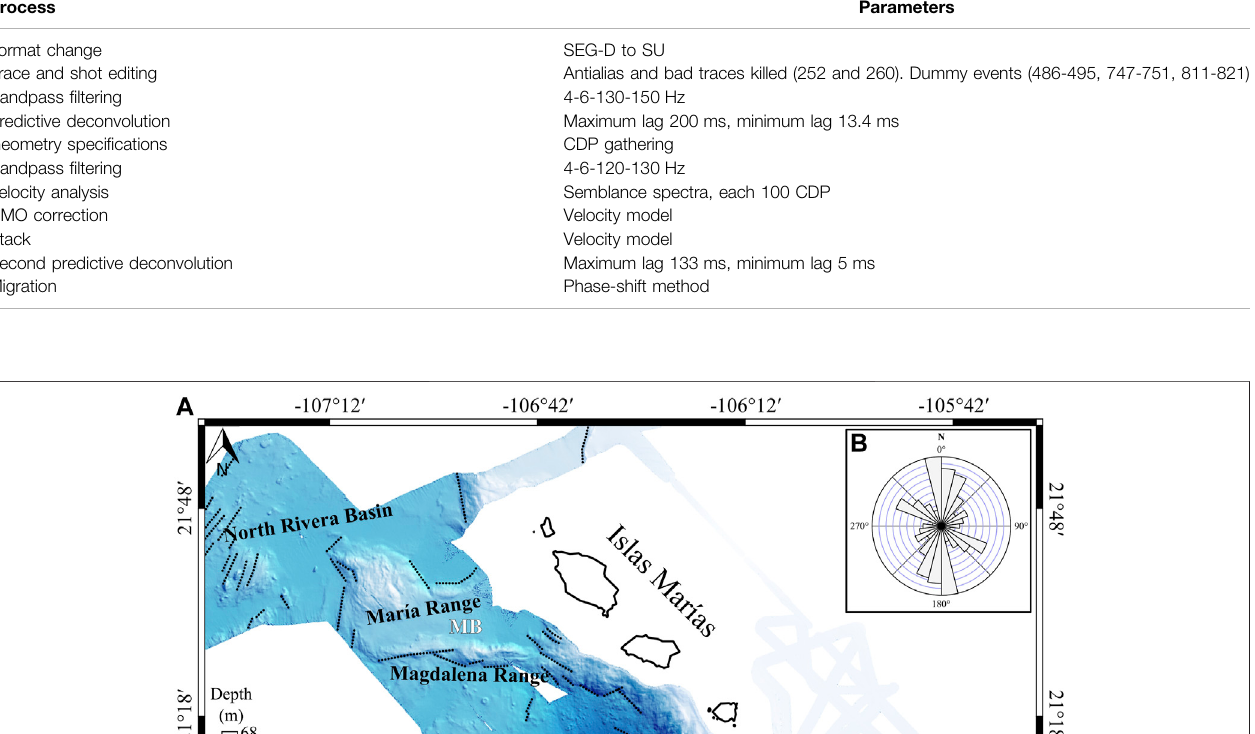
Frontiers in Earth Science |